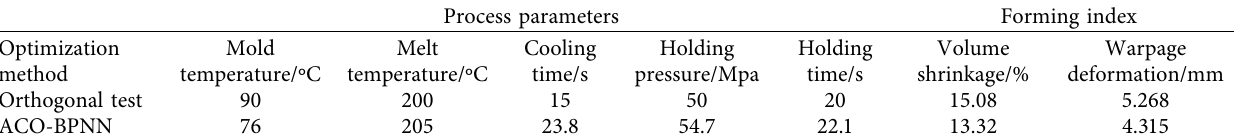
Figure 30: Warpage deformation diagram. Table 12: Result comparison